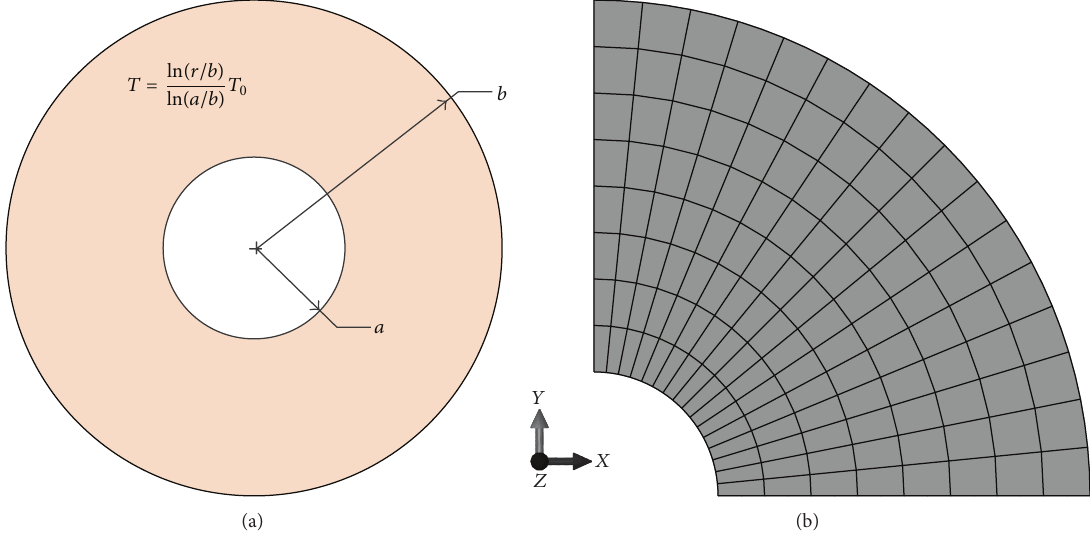
Figure 12: (a) Geometry and boundary conditions of the long cylinder with axisymmetric temperature change and (b) mesh configurations of a quarter of circular cylinder (128 eight-node